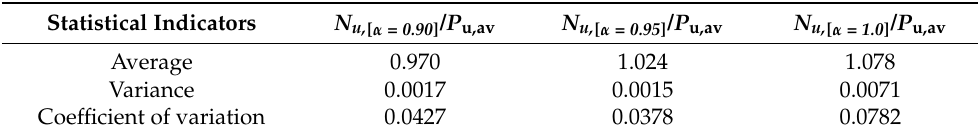
Table 5. Statistic indicators of different coefficient values.